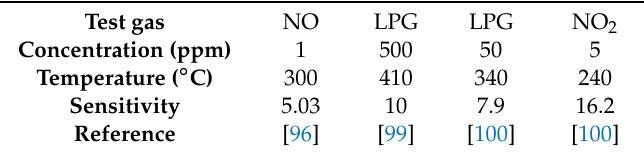
Table 9. Optimized performances of ZnGa 2 O 4 gas sensors.